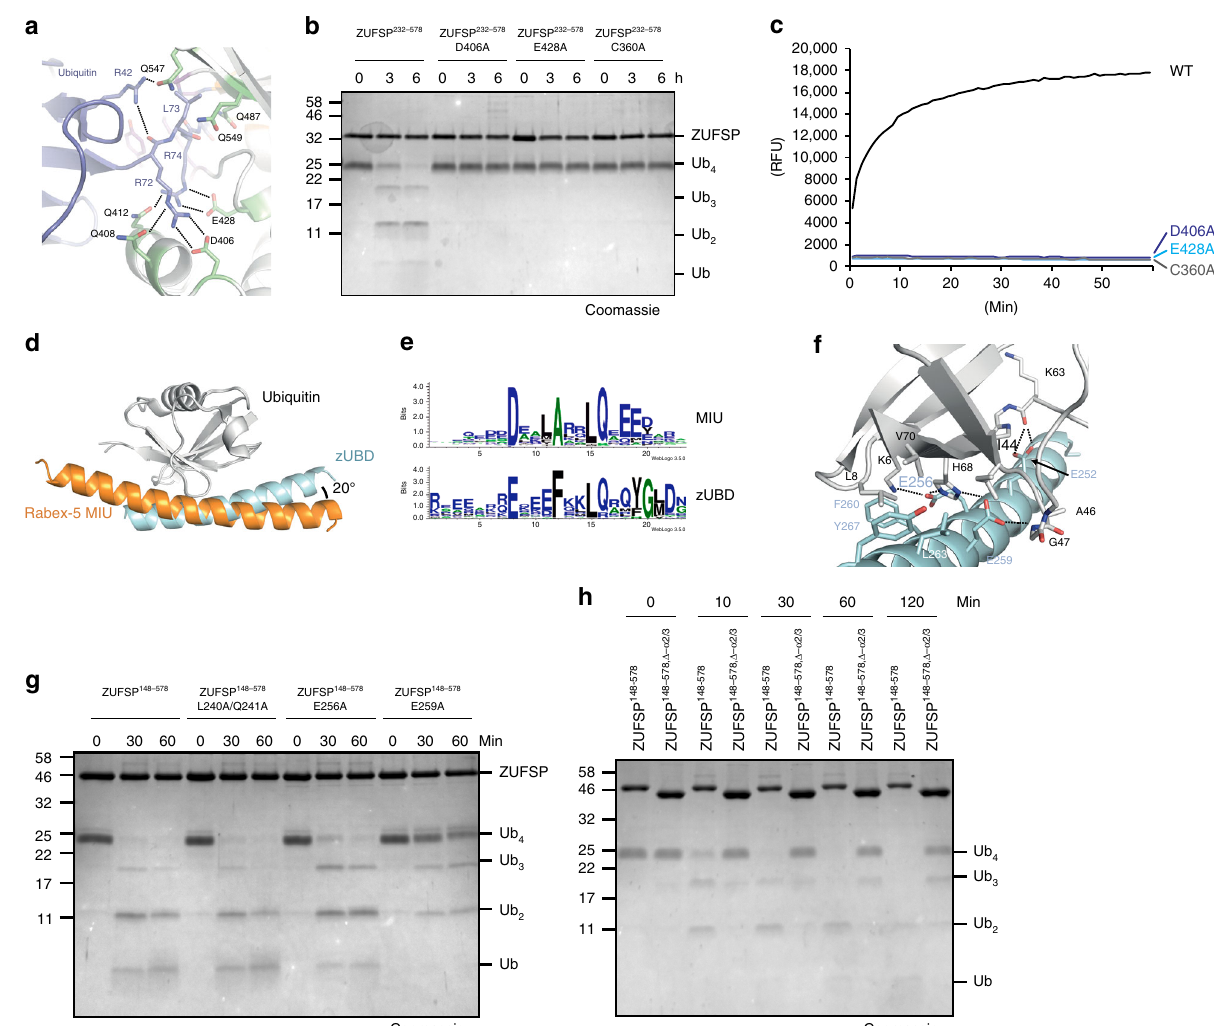
Fig. 5 Determinants of chain speci fi city. a Recognition of ubiquitin C terminus by the catalytic core of ZUFSP. Ubiquitin (blue) and ZUFSP (gray/green) shown in cartoon representation with key residues highlighted as sticks. Blue and black residue labels refer to ubiquitin and ZUFSP, respectively. Salt bridges are indicated by dotted lines. b Activity of C-terminus recognition mutants (ZUFSP 232 – 578 D406A or E428A) against K63-linked Ub 4 was compared to ZUFSP 232 – 578 and inactive ZUFSP (ZUFSP 232 – 578 C360A). c Activity of mutants described in b against RLRGG-AMC. The RFU values shown are the means of triplicates. d Structural superposition of ubiquitin-binding interfaces to zUBD (cyan, this work) and the MIU domain of Rabex-5 (2FIF, orange). Orientation of the two helical ubiquitin-binding domains differ by 20°. e SeqLogo 45 representation of the consensus sequences for the MIU motif 14 (top) and the zUBD derived from the ZUFSP family as shown in Supplementary Fig. 1 (bottom). f Magni fi cation of the interaction interface between ubiquitin and zUBD. Relevant residues are shown as sticks and labeled black in case of ubiquitin and cyan in case of zUBD. Electrostatic interactions are indicated as dotted lines. g Activity of a MIU mutant (ZUFSP 148 – 578 L240A/Q241A) and two zUBD mutants (ZUFSP 148 – 578 E256A and E259A) on K63- compared to activity of the parental ZUFSP 148 – 578 construct before the Ser-360, de fi nes the speci fi city of ZUFSP for the C that — despite the similar binding mode – the zUBD is not just an unusual MIU. Close contacts between the zUBD and ubiquitin are formed by two acidic residues (Glu-256 and Glu-259) (Fig. 5f), which differ in their importance for ubiquitin cleavage: while the E259A mutant was hardly active against Ub 4 , the E256A mutant showed only a modest reduction in activity (Fig. 5g). The N-terminal half of the ZUFSP α 1 helix is formed by its canonical MIU domain, but is not bound to ubiquitin and only partially resolved in the available structure. Nevertheless, the canonical MIU is ideally positioned to bind a distal S2-ubiquitin K63-linked to the outgoing S1 ubiquitin present in the structure. A double mutant targeting the highly conserved Leu-240/Gln-241 residues of the canonical MIU motif was equally active as wild-type